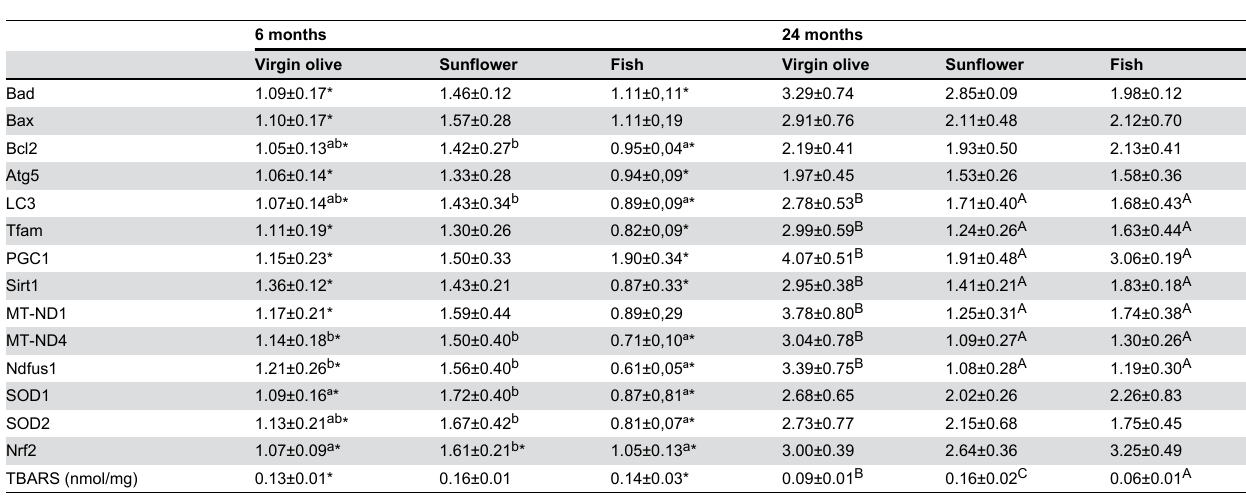
Table 5. Effects of dietary fat type on gingival mRNA levels (RQ) of genes related to apoptosis (Bad, Bax and Bcl2), autophagy (Atg5 and LC3), biogenesis (Tfam, PGC1 and Sirt1), mitochondrial electron transport chain (MT-ND1, MT-ND4 and Ndfus1) and antioxidant system (Nrf2, SOD1 and SOD2), as well as gum levels of thiobarbituric acid